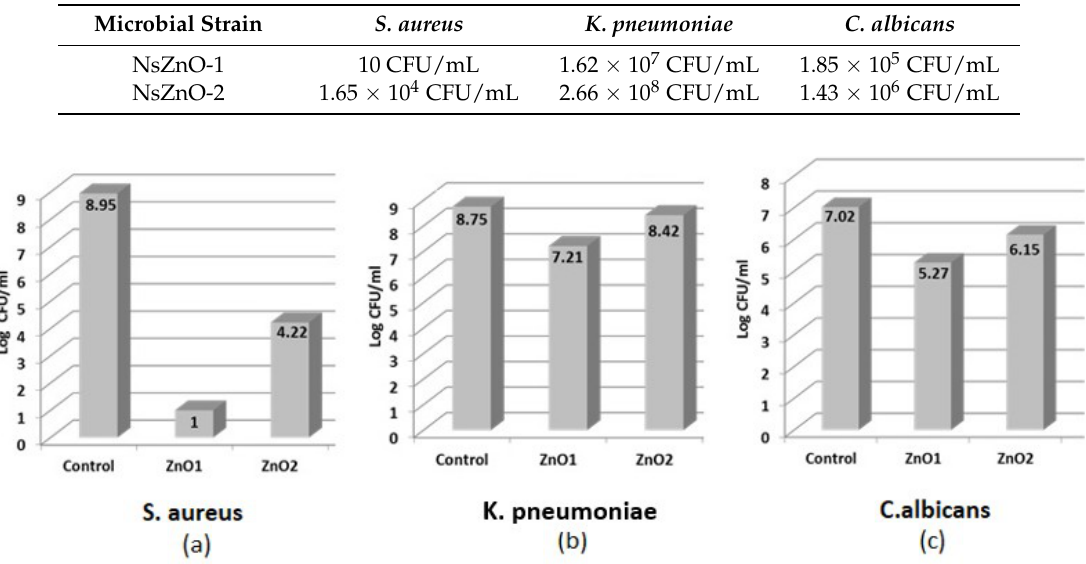
Table 4. Comparison of antibacterial/antifungal activity of NsZnO-1 and NsZnO-2 against S. aureus , K. pneumoniae , and C. albicans determined with the enumeration of viable microorganism assay and expressed in CFU/mL after 24 h of incubation.